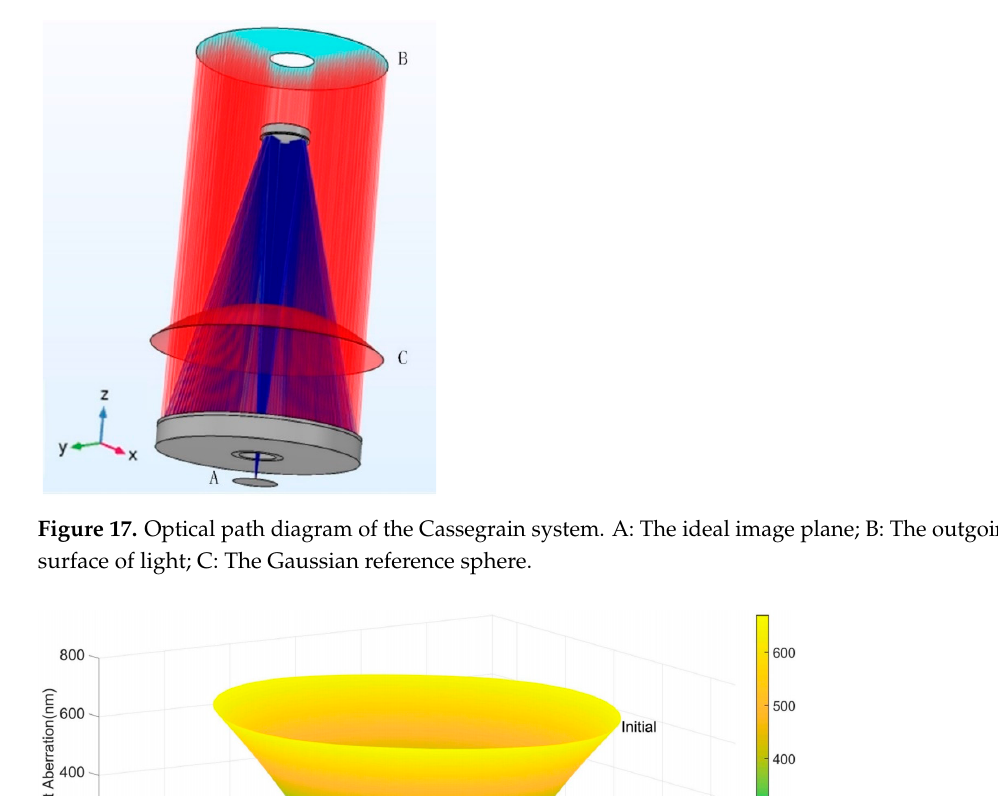
Figure 17. Optical path diagram of the Cassegrain system. A: The ideal image plane; B: The out- going surface of light; C: The Gaussian reference sphere. Table 4. Wavefront aberration coefficients of the initial and optimized systems in the vertical optical axis.